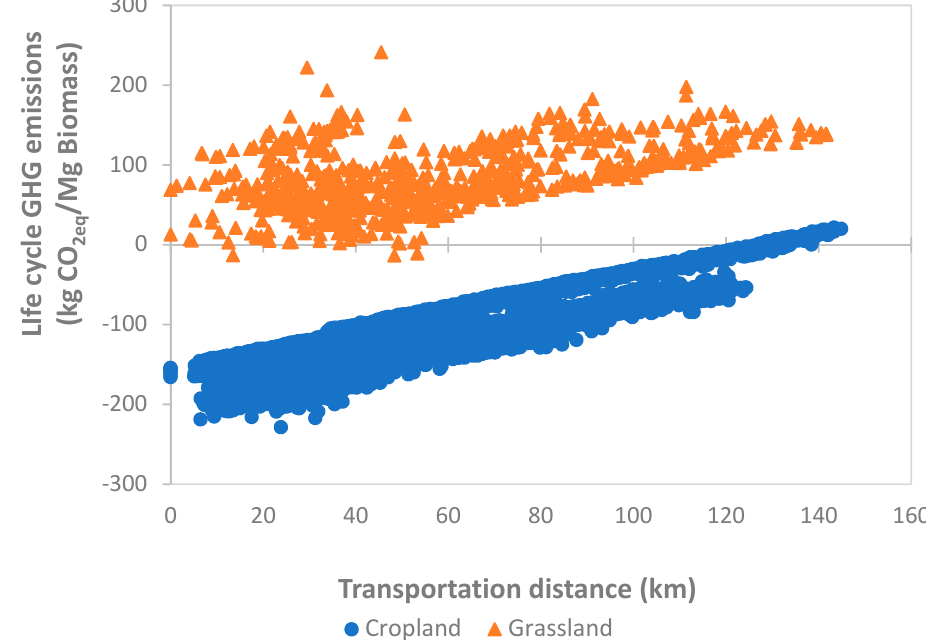
Figure 11. Parcel-level life cycle GHG emissions of five counties in shrub/grassland and pasture/cropland plotted against one way transportation distances.